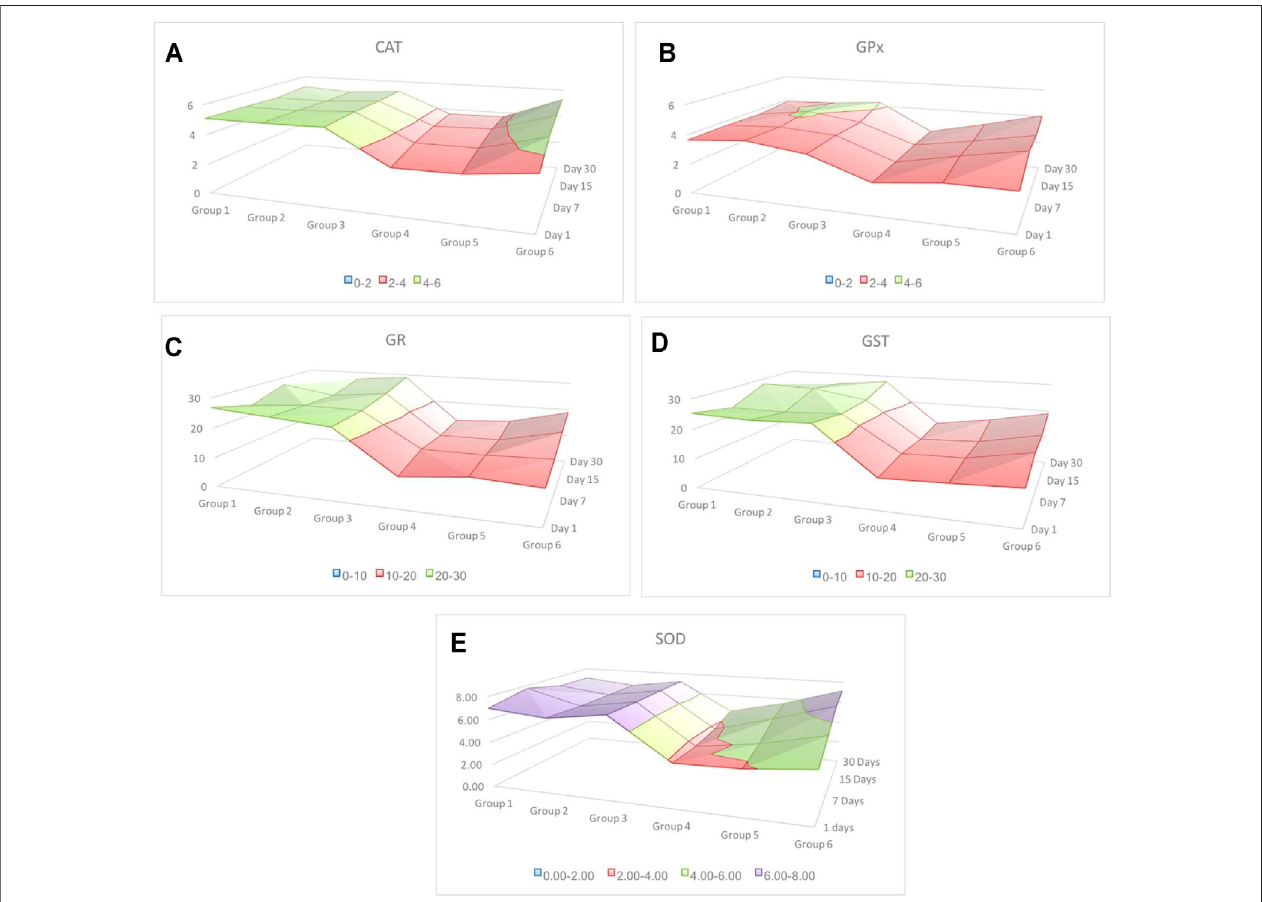
FIGURE 9 | Surface plot indicating alteration in the activity of antioxidants from day 1 to day 30 of most cause-and-effect – related antioxidants. Irrespective of individual numeric values, different colors indicate group-wise distribution of variation. Red color indicates the lowest and purple the highest. The alteration in the activity of SOD is the highest compared to the rest of the four antioxidant responses. Among all, GPx showed the lowest variation, whereas GR and GST indicated a similar response.